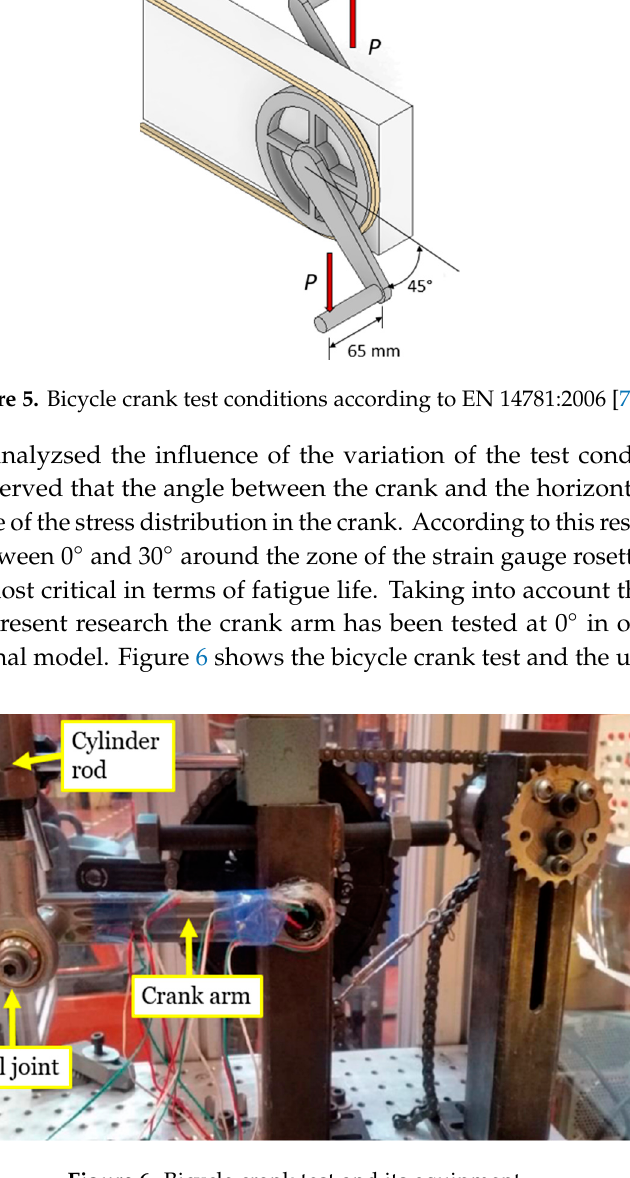
Figure 6. Bicycle crank test and its equipment.